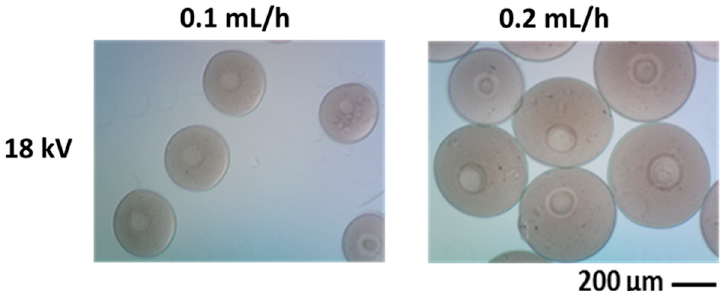
Figure 2. Chitosan microgels fabricated via EHDA: size variation via optical images as a function of flow